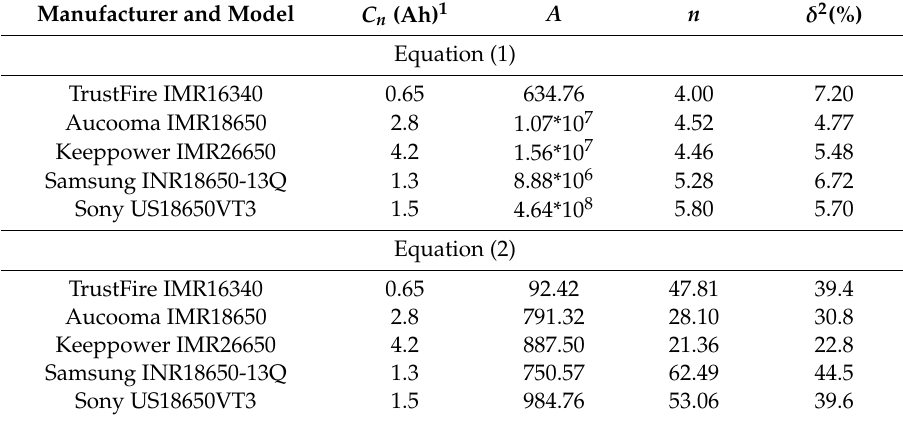
Table 3. Optimal parameters of Equations (1) and (2) for lithium-ion cells in the range of discharge currents from inflection point of experimental curve to the highest currents used in experiments.